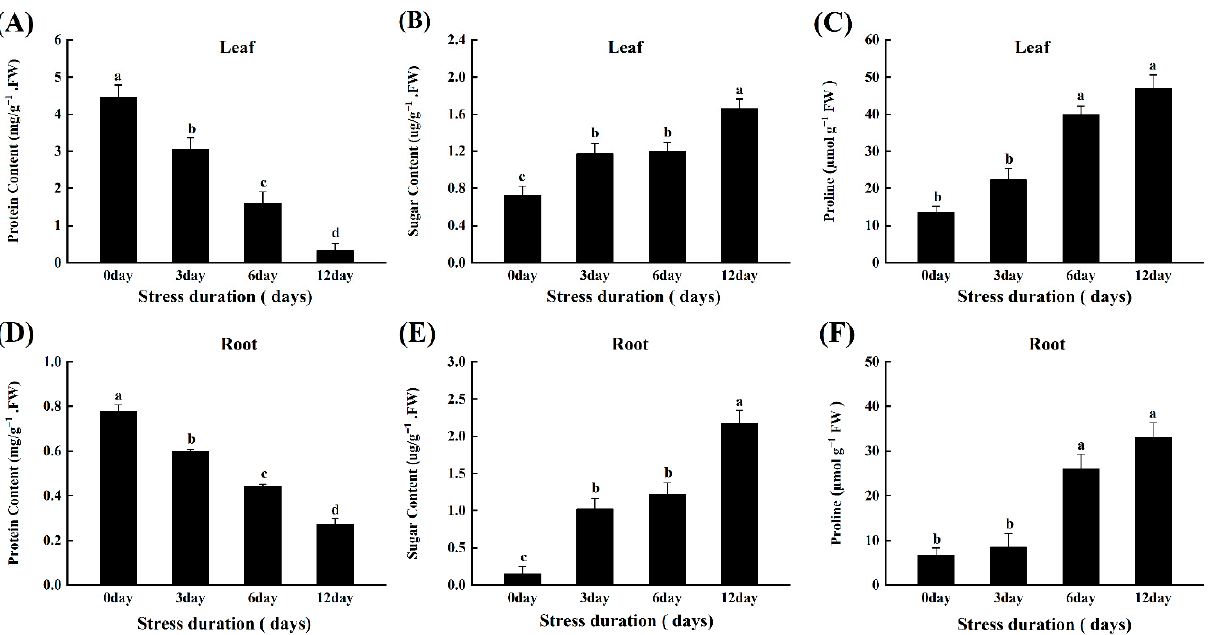
Figure 3. Effects of salt stress on protein content ( A , D ); Sugar content ( B , E ) and Proline ( C , F ) in leaves and roots of tomato seedlings grown for 12 days under control and salt stress. Values are mean ± SD (Standard Deviation) of three replications. Different letters indicate significant difference at p ≤ 0.05 (Tukey’s HSD test).